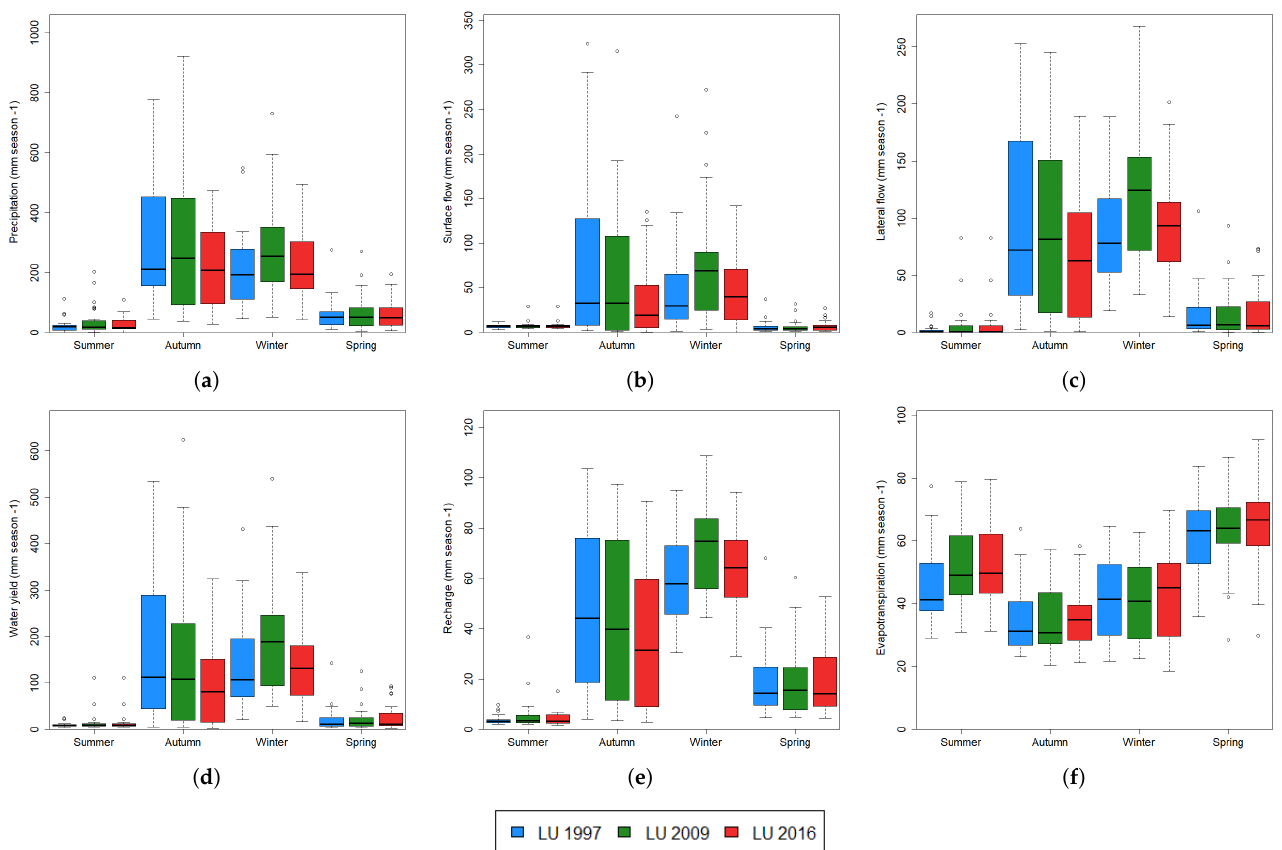
Figure 6. Seasonal average of the studied periods with LU 1997 (1990–1999), LU 2009 (2000–2009), and LU 2016 (2010–2019) for the parameters: ( a ) Precipitation, ( b ) Surface flow, ( c ) Lateral flow, ( d ) Water yield, ( e ) Recharge, and ( f )